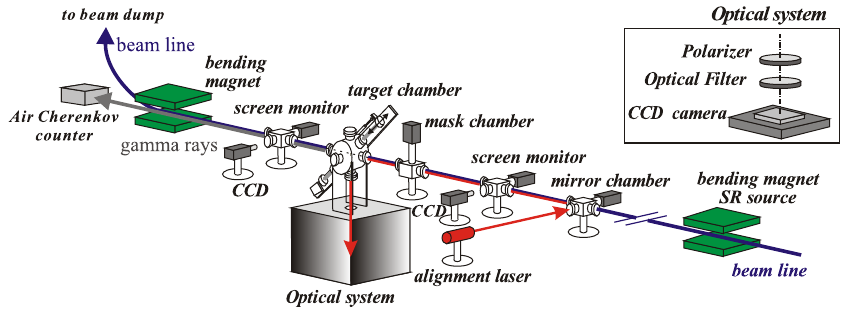
FIG. 2. (Color) Experimental setup.